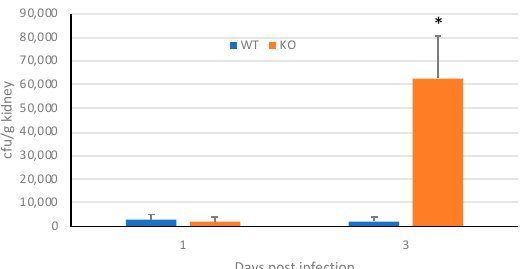
Figure 4. Growth of C. albicans in mBD-1 − / − mice. Female mice (C57BL / 6 and mBD-1 − / − , n = 5 per group) were injected with 3.5 × 10 5 cfu C. albicans and euthanized on days 1 and 3 post infection. Kidneys were homogenized and viable Candida were quantified by dilution plating. WT, C57Bl / 6; KO, mBD1 − / − . Data are shown as mean +/ – SEM. *, p =